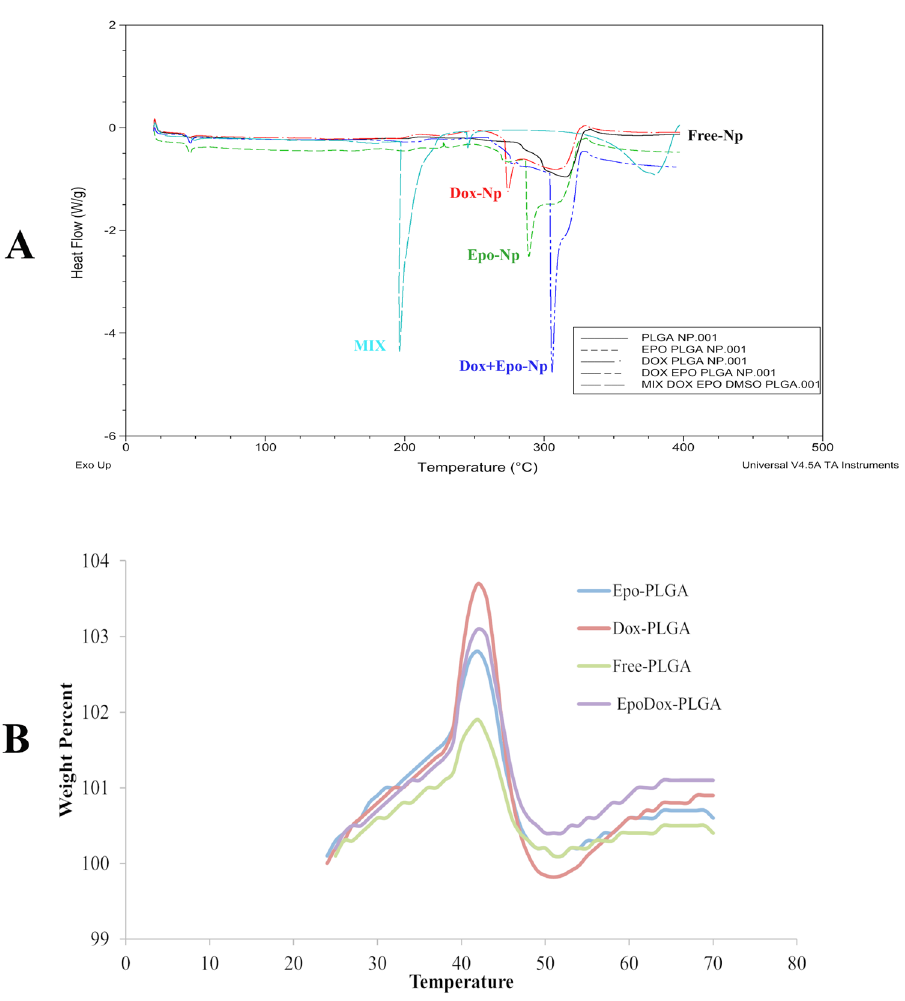
Figure 3. (A) Characterization of NPs by DSC. ( B) Characterization of NPs by